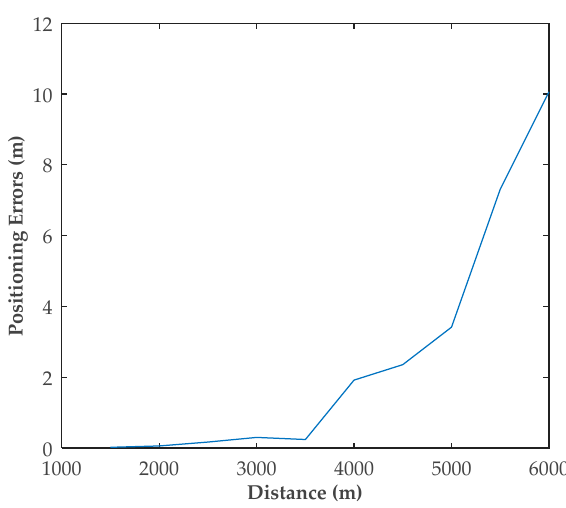
Figure 8. Positioning results at different distances.